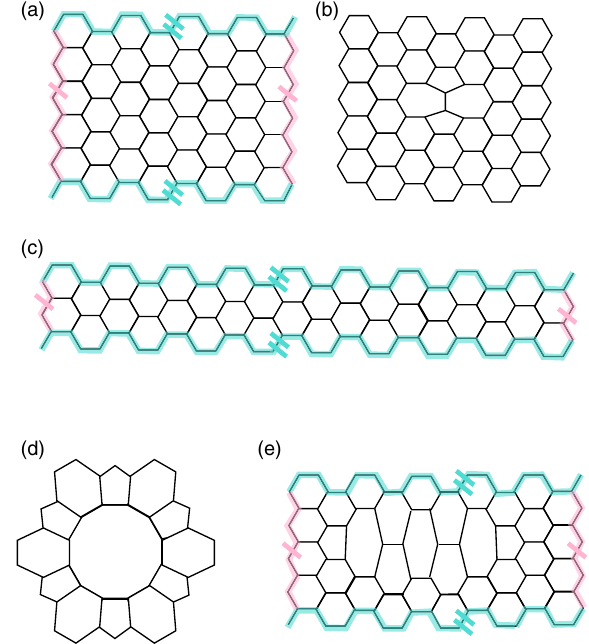
FIG. 6. (a) Honeycomb lattice on a toroidal topology. Opposite sides are identified as shown. (b) T1 topological rearrangement on a honeycomb lattice. (c) One-holed torus with a thin handle. (d) A tile with a large number of sides as a result of condensation of disclination charges. (e) Varicosity as a result of a condensation of like-charged dislocation defects. Opposite sides are identified as shown, resulting in the topology of a one-handle